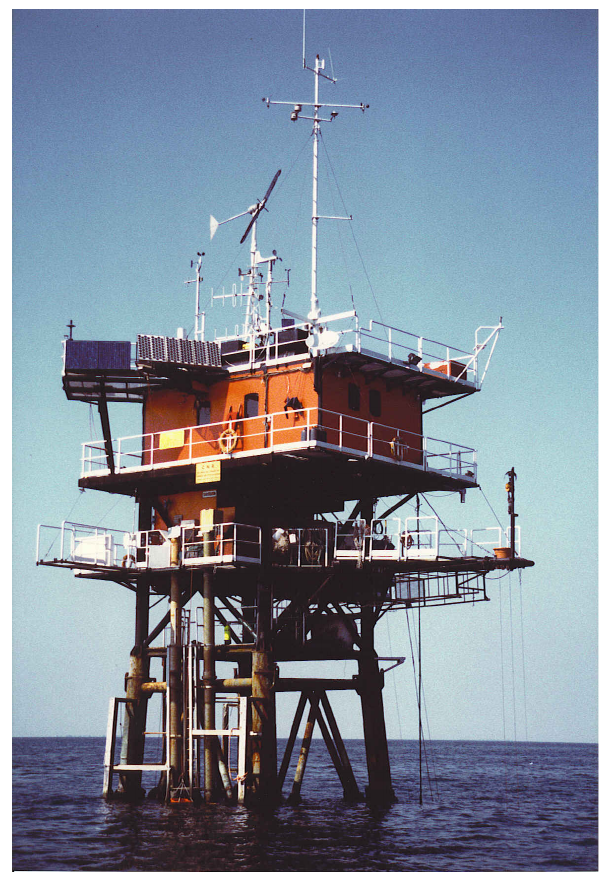
Figure 2. Thr oceanographic Observation Tower in Adriatic Sea. Fig. 2. The oceanographic Observation Tower in Adriatic